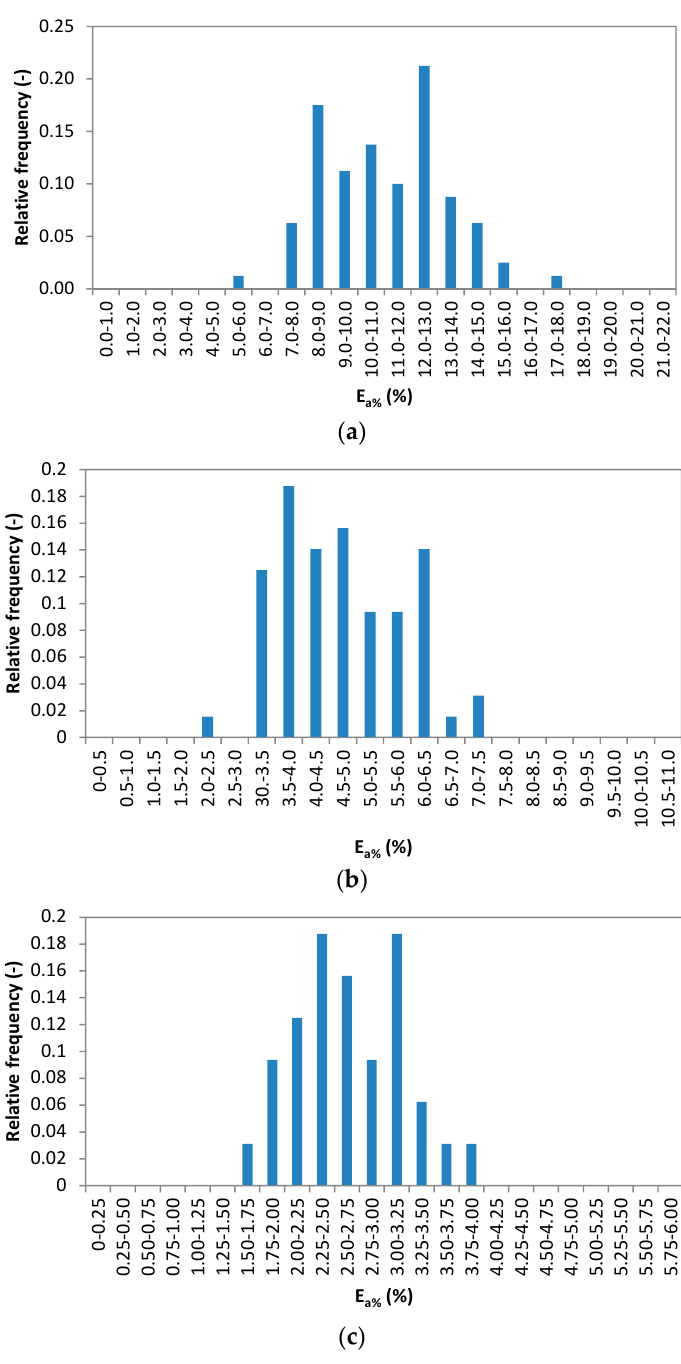
Figure 9. Relative frequency of the average underestimation error, E a% , of the maximum rainfall depth, which considers the classes’ amplitudes shown in the x ‐ axis. ( a ) t a / d = 1, ( b ) t a / d =0.5, and ( c ) t a / d = 0.333. All selected rain gauge stations and all possible combinations of t a and d were considered.